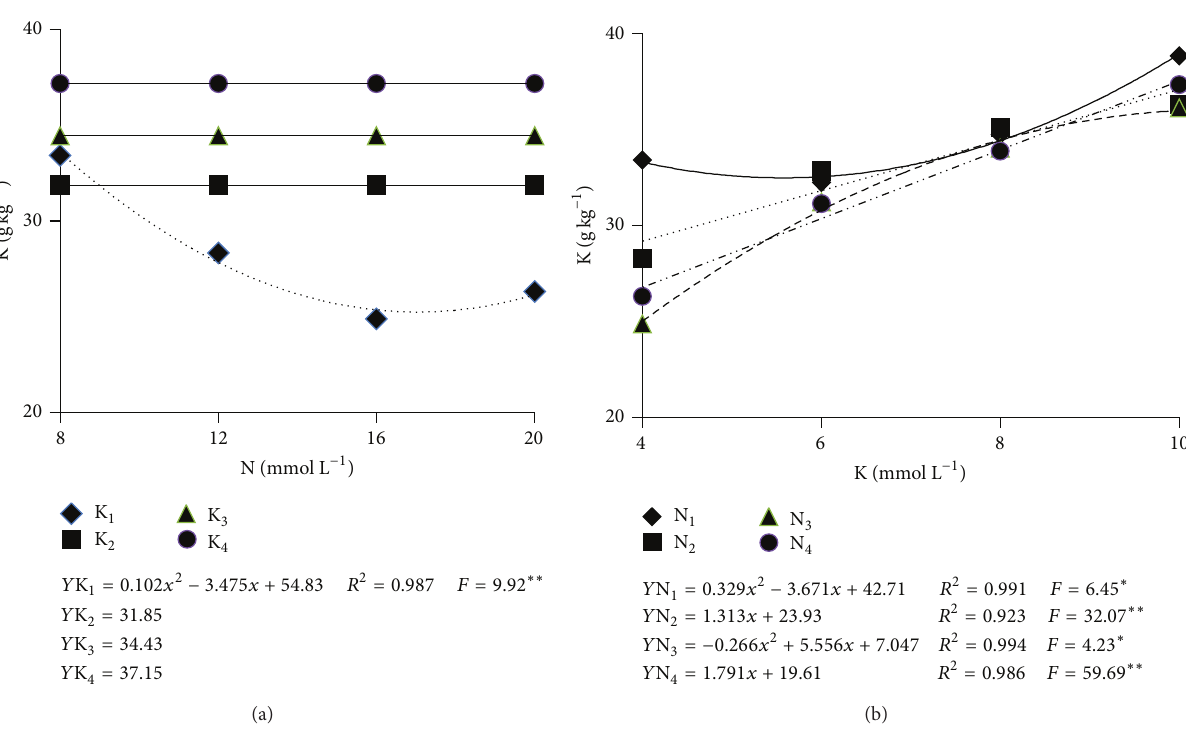
Figure 2: K content in the leaf used for the evaluation of the nutritional status of “Bonus no. 2” melon plants as influenced by N (a) and K (b) concentrations in the nutrients solution. ∗∗ , ∗ : Significant at the levels of 1 and 5%, respectively, according to the 𝐹 test.